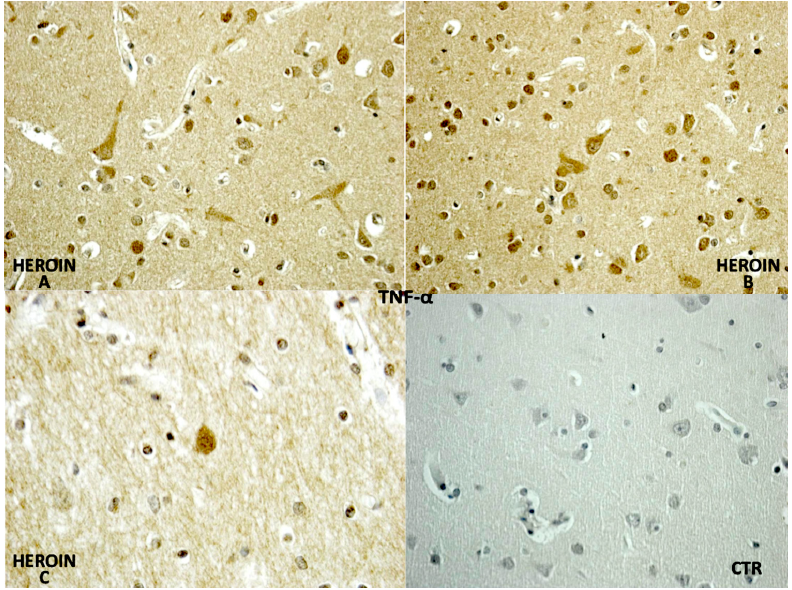
Figure 3. TNF- α was expressed in the heroin-related death group: note the intense neuronal and glial reactions ( A – C ), and the negative control group (CTR).